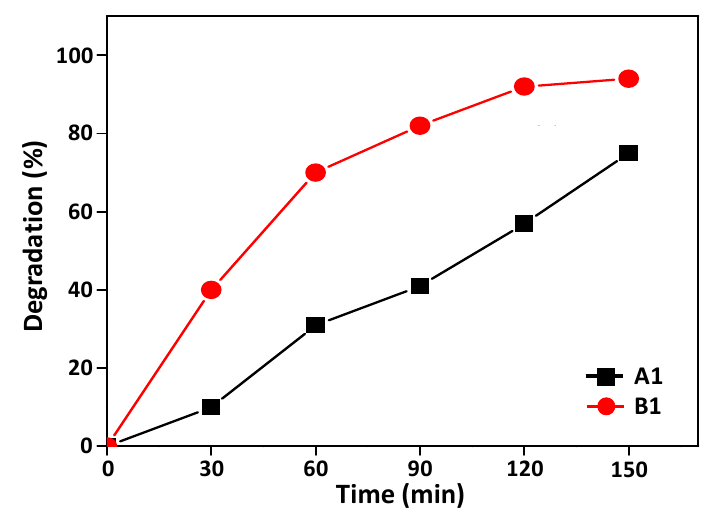
Figure 7. Degradation efficiency of catalysts A1 and B1 .